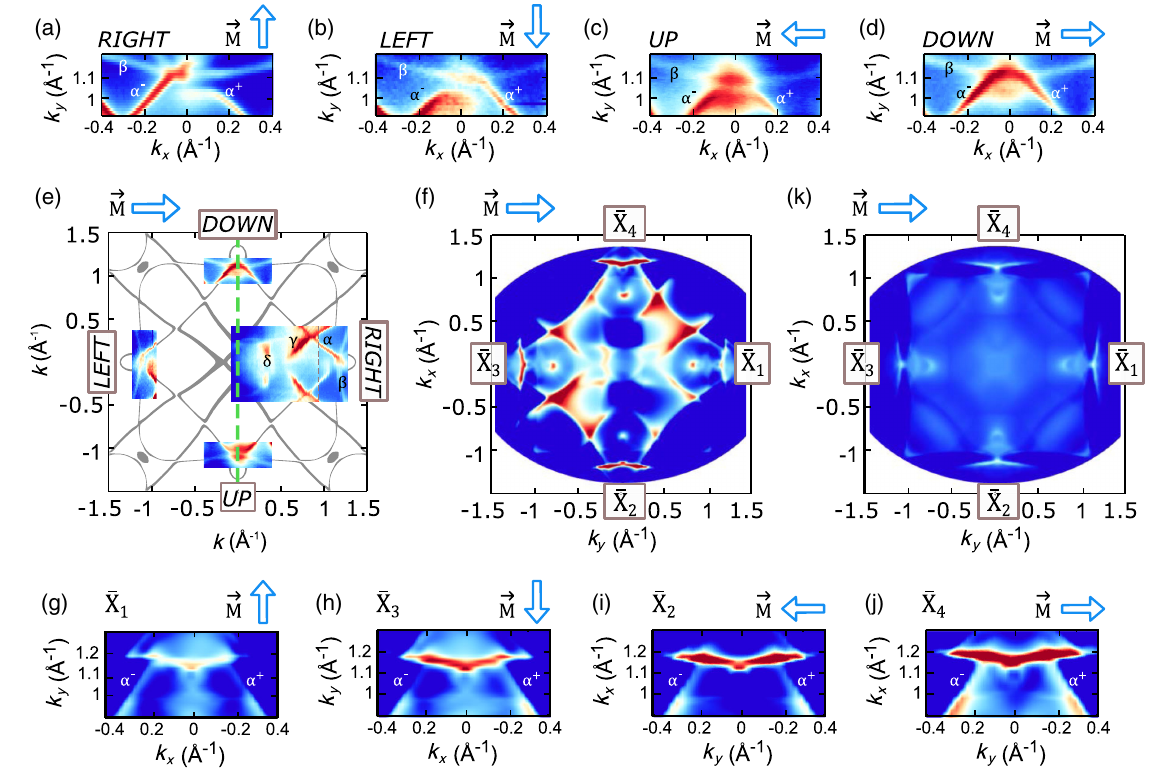
¯ FIG. 5. (a) – (d) Electronic structure of Fe(001) close to the X point of the SBZ for four different in-plane easy magnetization directions measured at h ν ¼ 16 . 8 eV. (e) Fermi surfaces derived from (a) – (d) arranged with respect to the fixed magnetization direction (arrow); this approximation is applicable when the role of the light incidence direction is neglected. The gray line depicts the electronic band structure of the bulk k ⊥ ¼ 2 . 2 Å − 1 calculated using the GW method. The dashed vertical line marks the mirror plane. (f) Result of the one-step model photoemission calculation that shows spectral intensities within the entire SBZ. The arrow marks the magnetization direction. (g) – (j) Results of the one-step model photoemission calculation shown for the fractions of the k space that correspond to experimental Fermi surfaces presented in (a) – (d). (k) Result of the one-step model photoemission calculations performed without the d - f transitions. All the one-step model photoemission calculation results shown are obtained with intentionally quenched surface contribution and the light incidence direction along the